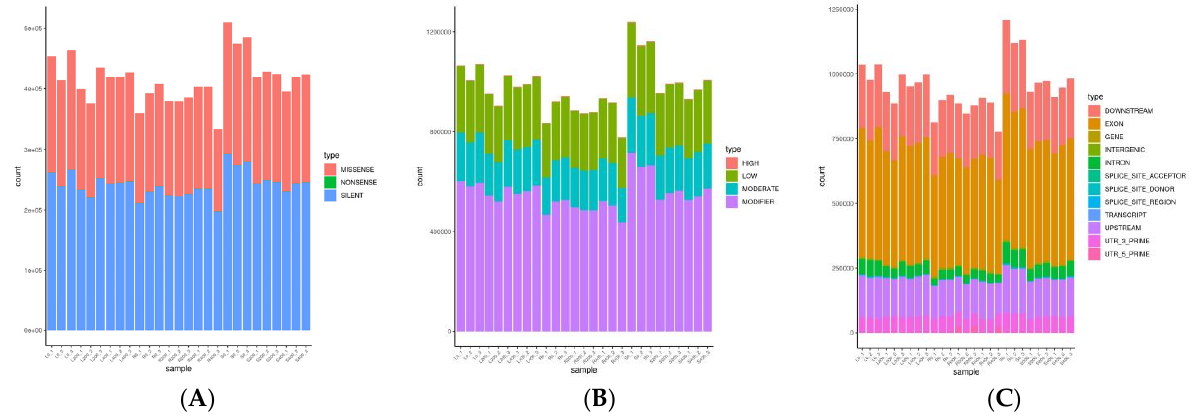
Figure 9. Mutation loci analysis. ( A ) Functional statistics of mutants. ( B ) Statistical diagram of influences of locus variation. ( C ) Regional statistical map of variation loci.